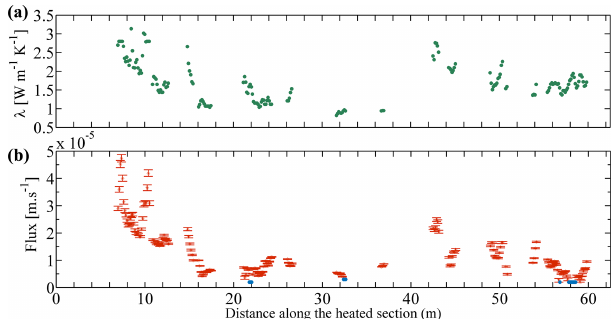
Figure 8. The interpretation of active DTS measurements along the heated section of FO cable leads to the estimation of the spatial distribution of both (a) the thermal conductivity (uncer- tainty =± 0.2Wm − 1 K − 1 ) and (b) the water fluxes and their as- sociated errors (error bars). Blue points mark locations where the temperature stabilization is not reached and where an estimate of q lim is provided. Errors bars corresponding to uncertainties on flow estimates calculated with respect to data noise for each measure- ment points are